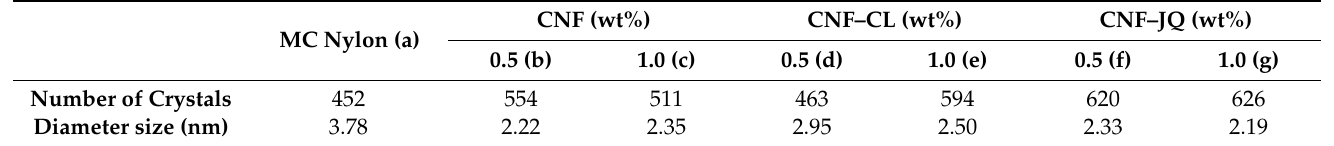
Table 1. Nucleation density and grain size of MC nylon and MC nylon